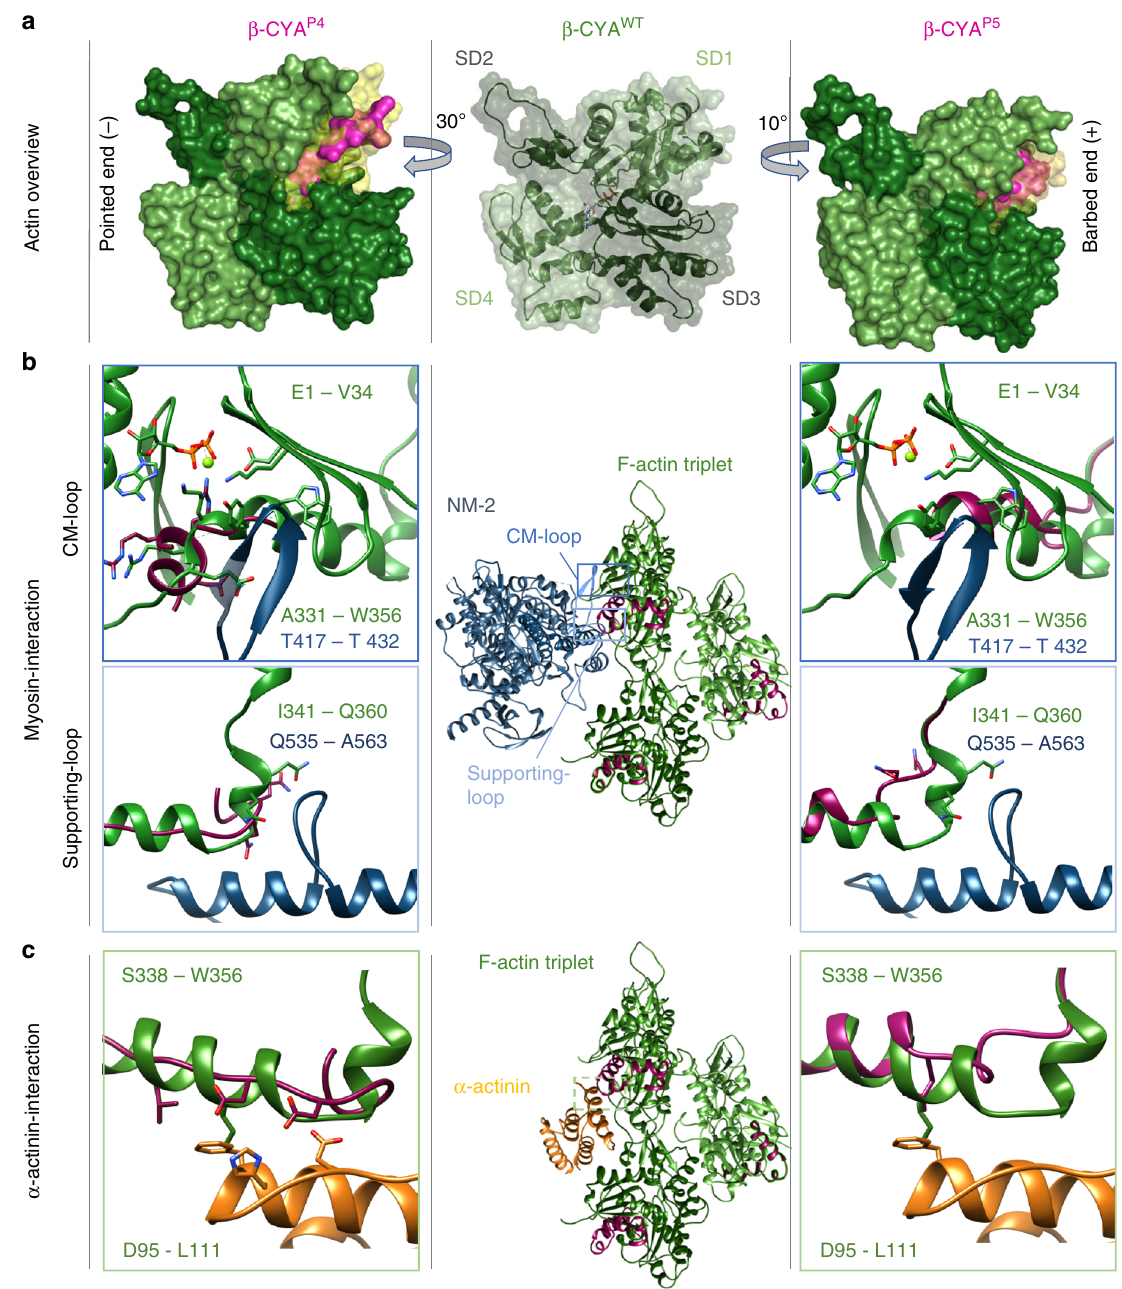
Fig. 6 In silico modeling of P4- and P5-associated ACTB variants. a Overview of wildtype (WT) β -CYA (mid) in cartoon with space- fi ll overlay. β -CYA P4 and β -CYA P5 to the left and right respectively, with missing volumes indicated in yellow space- fi ll and affected residues modeled in magenta space- fi ll; b The binding interface of NM-2 (blue, according to PDB 5JLH) on a β -CYA WT F-actin triplet (mid, green with magenta C-terminal residues) is shown. Close-ups of affected β -CYA P4 (left) and β -CYA P5 (right) residues are superimposed as magenta cartoon structures on the green β -CYA WT cartoon structure. CM-loop interactions with mutant actins are shown in the top panels, whilst supporting-loop interactions are modeled in the lower panels; c In silico modeling of the interaction interface of β -CYA WT (green) with α -actinin (orange, according to PDB 3LUE, con fi rmed by docking) is shown (mid). Left and right show the interface with affected C-terminal residues for β -CYA P4 (left) and β -CYA P5 (right),